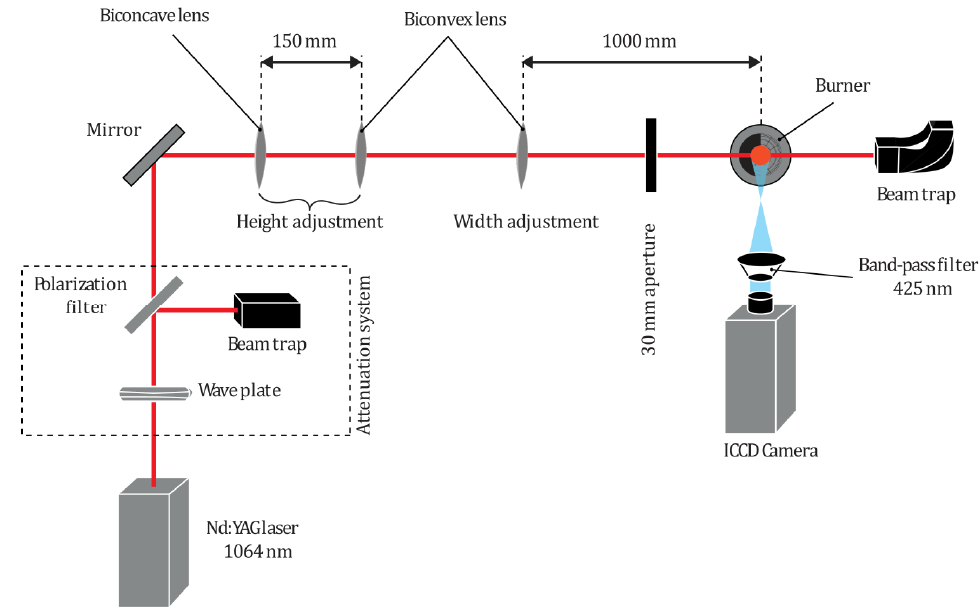
Figure 2. LII set-up used for comparative measurements. Red lines depict the path of the laser beam. For the measurements we utilized a fluence of 0.15 J/cm 2 , selected after optimization of the fluence in relation to the LII signal intensity (see [74]). The 2D-LII images were col- lected through an intensified CCD camera (Andor, iStarDH334T-18F-E3, 16 bit). The in- tensifier gate width was set to 20 ns, the repetition rate to 10 Hz and the pixel resolution set was 354 × 301 pixels. In front of the objective lens of the camera a band-pass filter